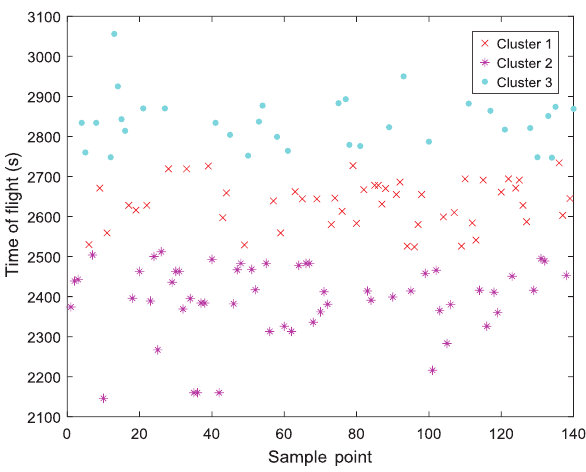
Figure 6: Time k-Means Clustering